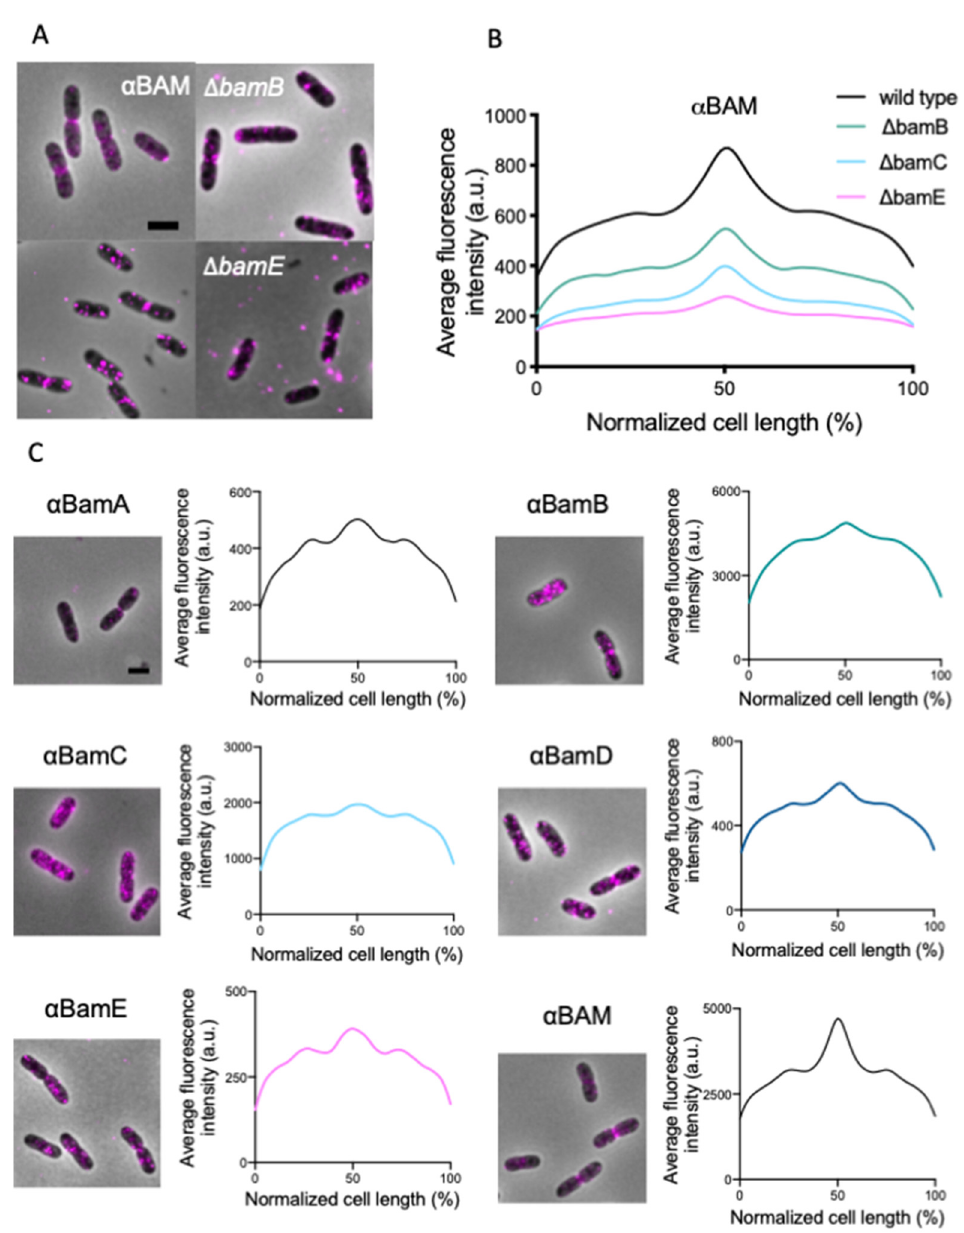
Figure 2. E. coli BAM mutants immunolabelled with α BAM and immunolabelling of single BAM subunits ( α BamA-E). ( A ) Fluorescence microscopy images of BW25113 wild type and mutant cells